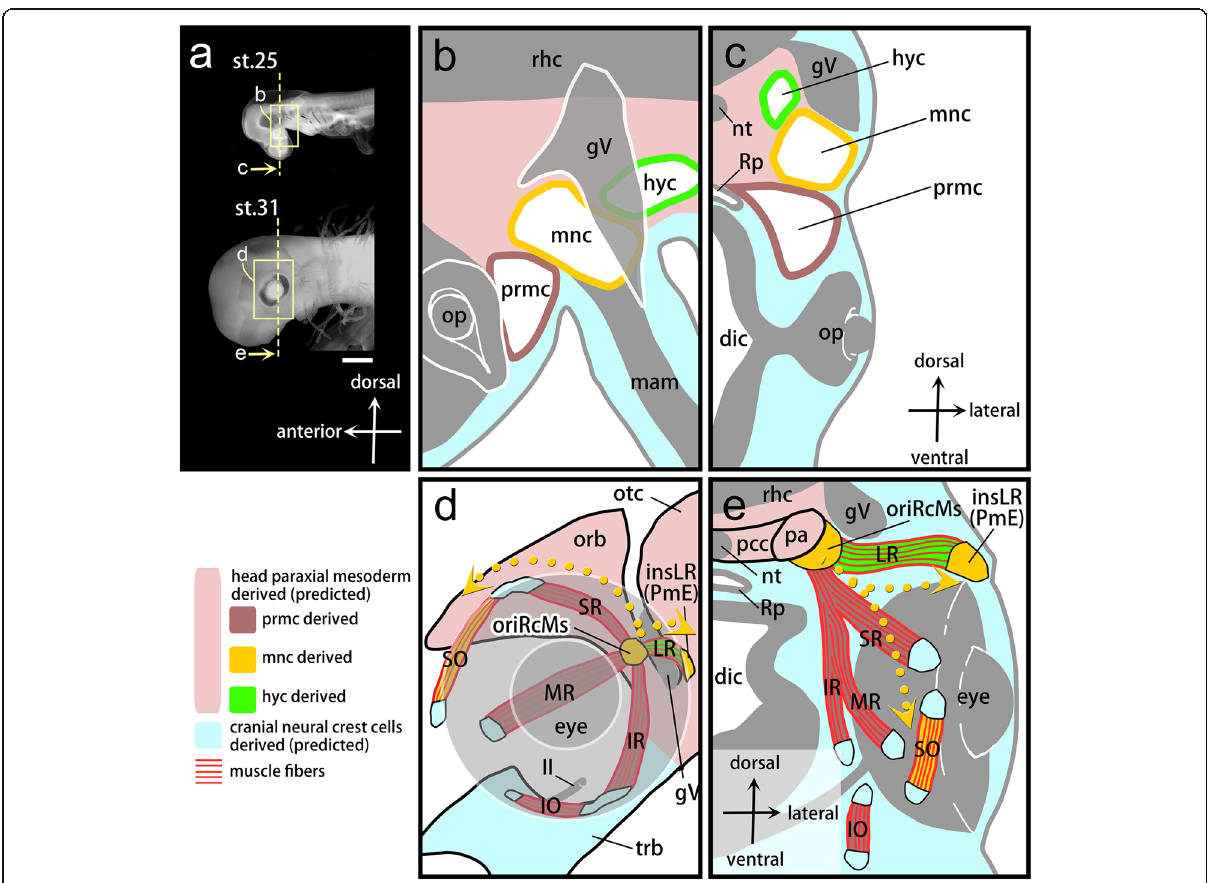
Fig. 6 Developmental fates of shark head cavities in the musculoskeletal system of extraocular muscles. a Left lateral view of the shark embryos at st. 25 (top) and st. 31 (bottom). b, c Schematic drawings of a left lateral view of the inset in ( a ) and a transverse section at the level of the dashed line in ( a ) showing HCs arranged along the anteroposterior axis ( b ) and the dorsoventral axis ( c ) in the embryonic head at st. 25. d, e Schematic drawings of a left lateral view of the inset in ( a ) and a transverse section at the dashed line level in ( a ) showing musculoskeletal connections in EOMs via tendons at st.31. The colors of each musculoskeletal component correspond to its developmental origin, shown in ( b and c ). Yellow dotted arrows represent the dynamic migratory pathways of mnc-derived cells reconstructed based on the results of the present study. The developmental fate of CNC cell-derived tendons (light blue) and mesodermal chondrocranium (pink) are based on the prediction. II, optic nerve; dic, diencephalon; gV, trigeminal ganglion; hyc, hyoid head cavity; insLR, a tendon at the insertion of the lateral rectus muscle; IO, inferior oblique muscle; IR, inferior rectus muscle; LR, lateral rectus muscle; mam, mandibular arch mesoderm; mnc, mandibular head cavity; MR, medial rectus muscle; nt, notochord; op, optic cup; orb, orbital cartilage; oriRcMs, a tendon at the origin of four-rectus muscles; otc, otic capsule; pa, pila antotica; pcc, parachordal cartilage; pm, PmE, Platt ’ s ‘ muscle E ’ ; prmc, premandibular head cavity; rhc, rhombencephalon; Rp, Rathke ’ s pouch; SO, superior oblique muscle; SR, superior rectus muscle; trb, trabecular cartilage. Scale bars = 1 mm. Not to scale ( b - e